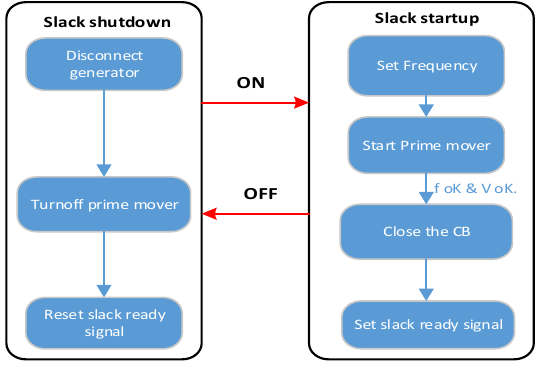
Figure 12. Slack generator control.